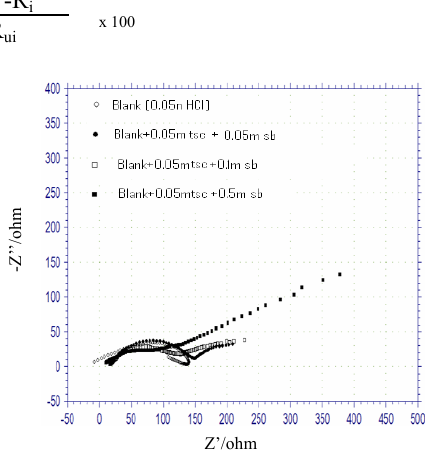
Figure 6. Nyquiste plot of mild steel in 0.01N HCl in absence and presence of various concentration of citrate and benzoate inhibitors